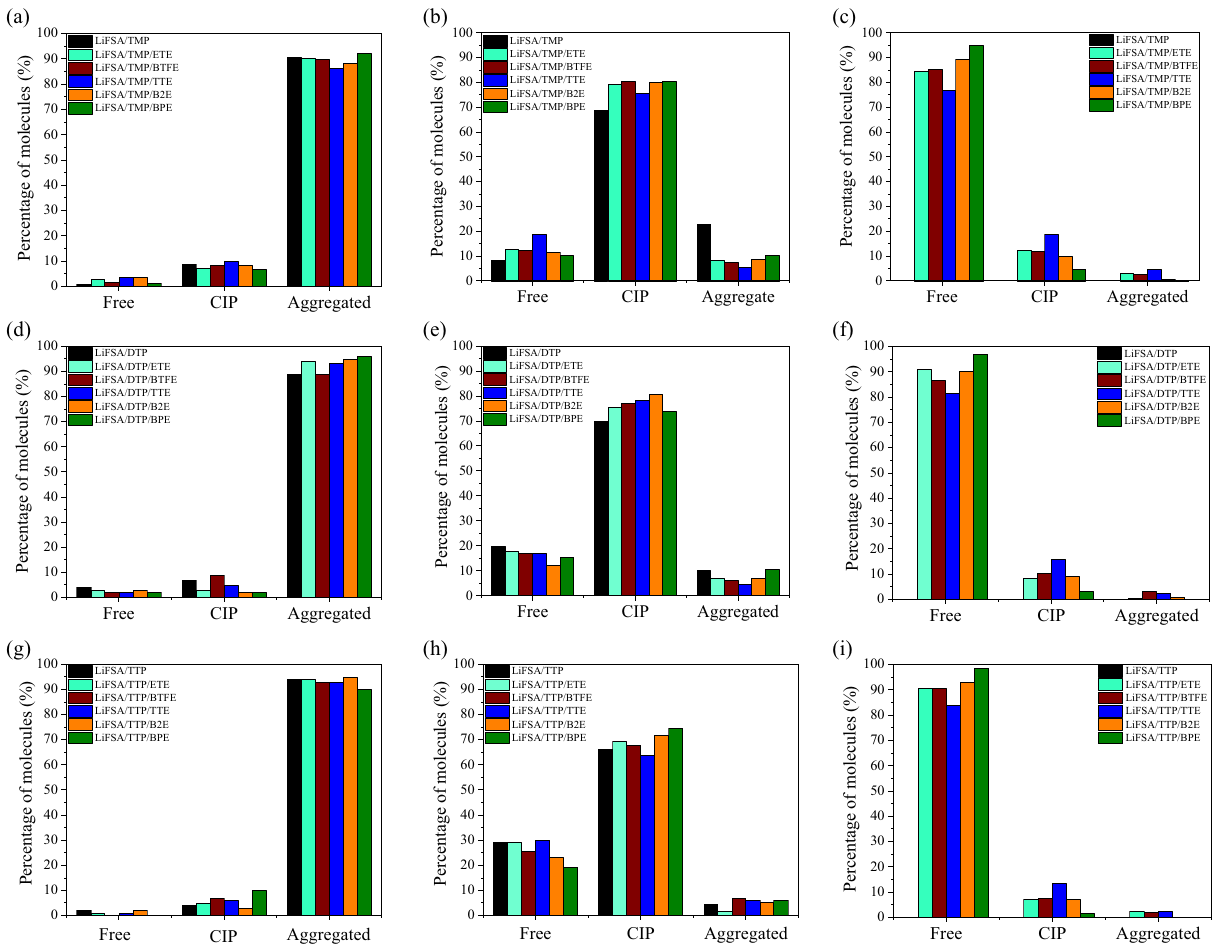
Figure 1. Averaged percentage of three main states of ( a ) salt anion, ( b ) TMP solvent and ( c ) ether diluents in TMP-based diluted electrolytes; ( d ) salt anion, ( e ) DTP solvent and ( f ) ether diluents in DTP-based diluted electrolytes; and ( g ) salt anion, ( h ) TTP solvent and ( i ) ether diluents in TTP-based diluted electrolyte solutions. The considered molar ratios were 1:1.3 for salt and solvent in HC electrolyte and 1: 1.3:2 for salt, solvent and diluents in the diluted